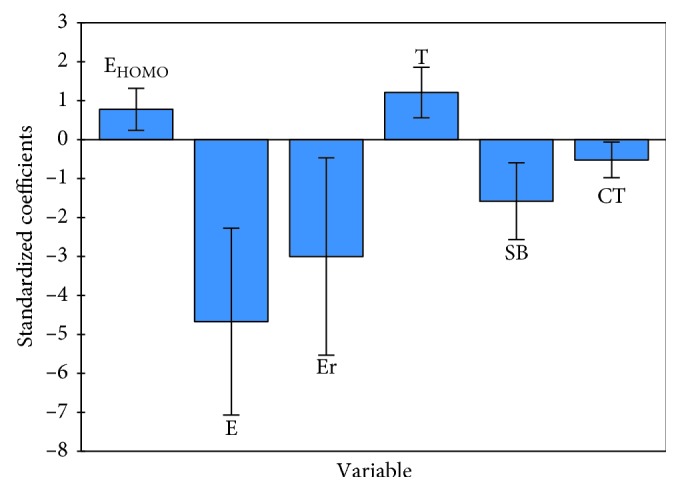
Modeling characterization by the normalized coefficients.